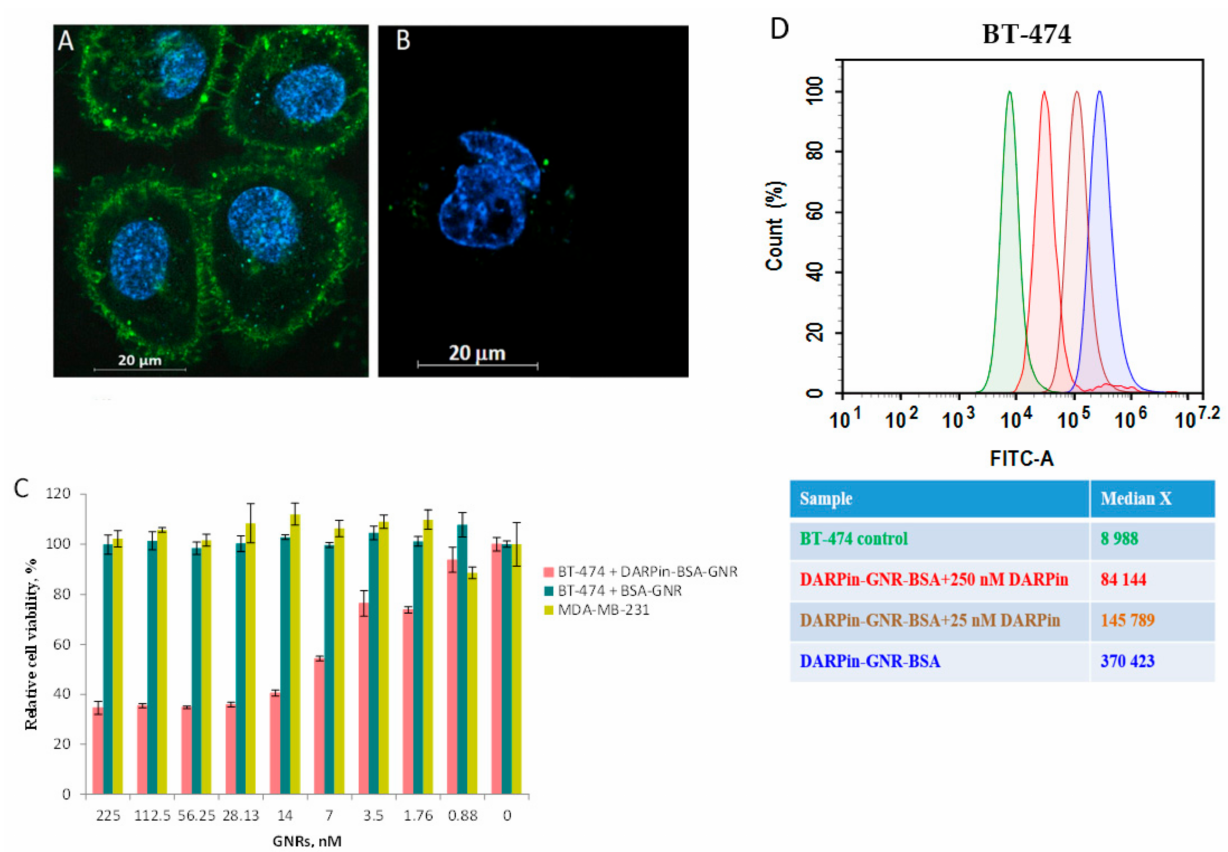
Figure 3. In vitro characterization of DARPin-BSA-GNRs. Confocal images of HER2-overexpressing BT-474 cells ( A ) and MDA-MB-231 cells ( B ) characterized by HER2 expression normal for epithelial cells. Fluorescence-merged images of cells in green (FITC-labeled DARPin-GNRs) and blue (Hoechst 33342) channels are presented. ( C ) In vitro cell viability of BT-474 cells treated with DARPin-BSA-GNRs (pink columns) or BSA-GNRs (cyan columns) and MDA-MB-231 cells treated with DARPin-BSA-GNRs (dark yellow columns) and exposed to illumination. Error bars represent the standard deviation ( n = 3). ( D ) Normalized flow cytometry histograms showing specific interaction of DARPin-BSA-GNRs with HER2 receptors on the surface of BT-474 cells in the absence (blue peak) and presence of 250 (red peak) or 25 nM (brown peak) free